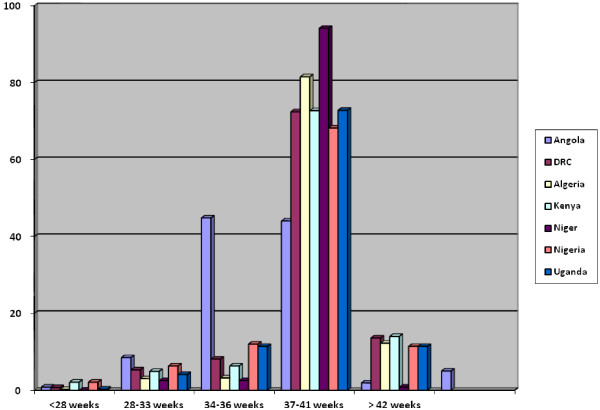
Percentage distribution of gestational age at induction of labor by country.